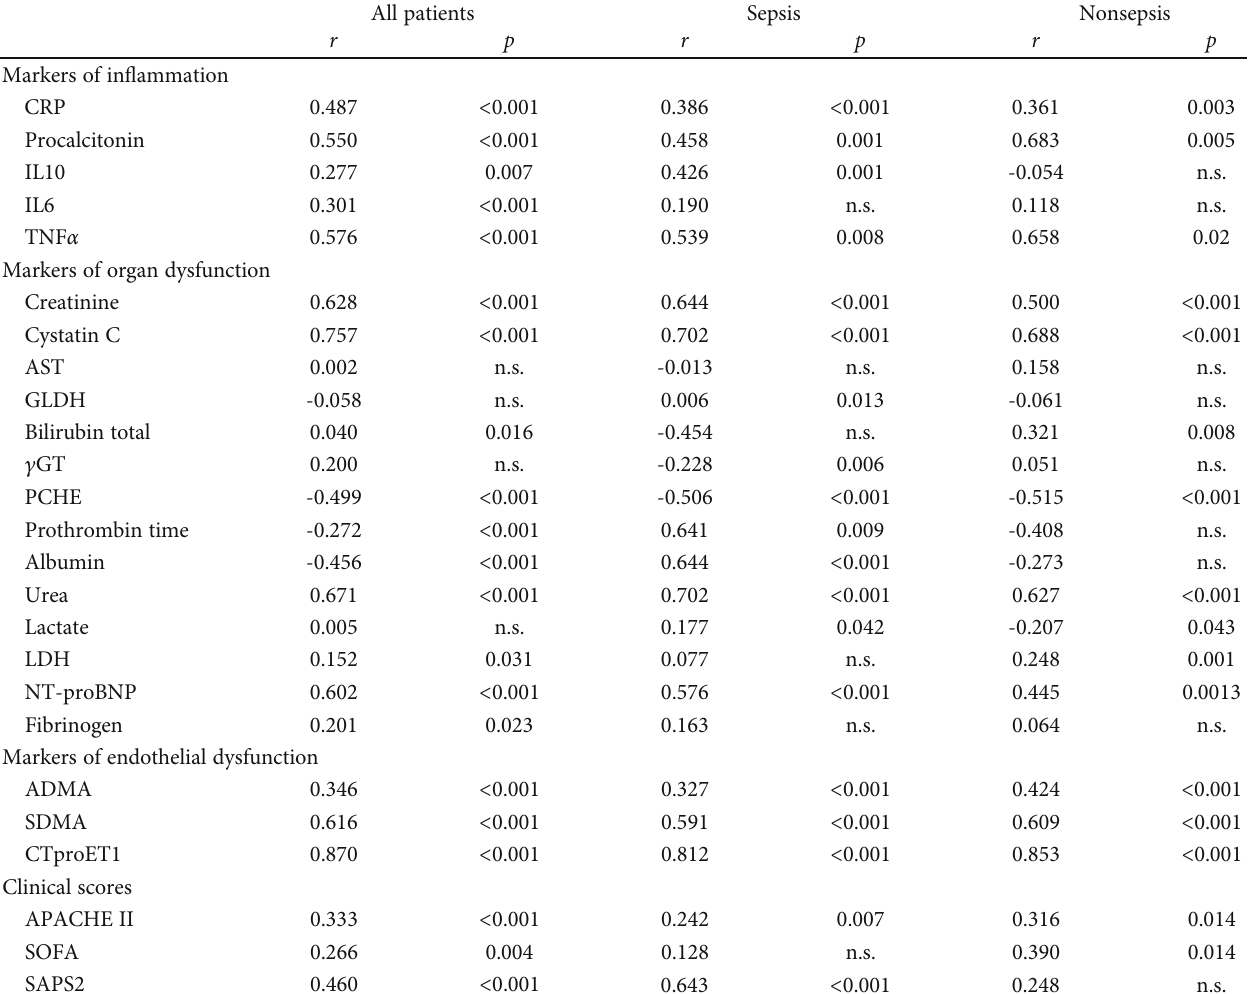
Table 3: Correlations of MRproADM with clinical scores and biomarkers of in fl ammation, organ failure and endothelial dysfunction, Spearman rank correlation